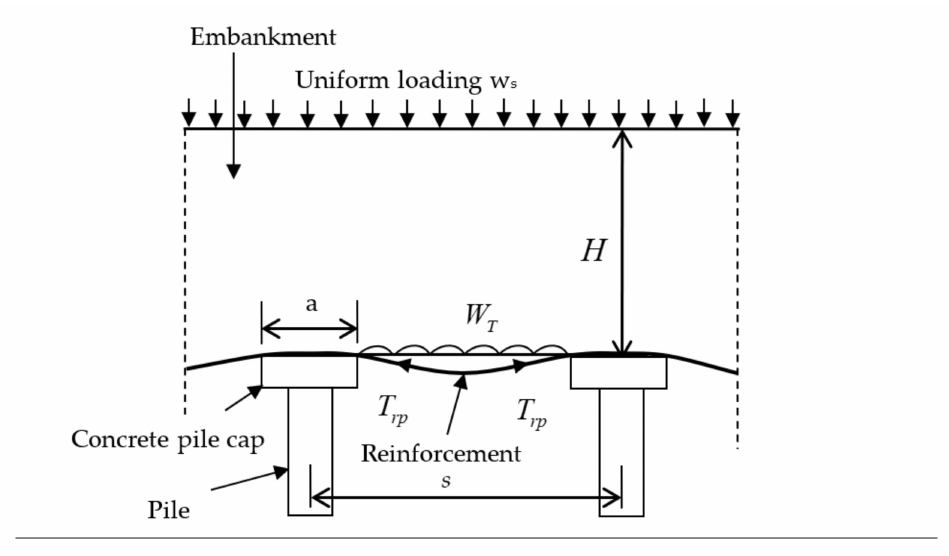
Figure 6. Parameters used in the calculation of T rp